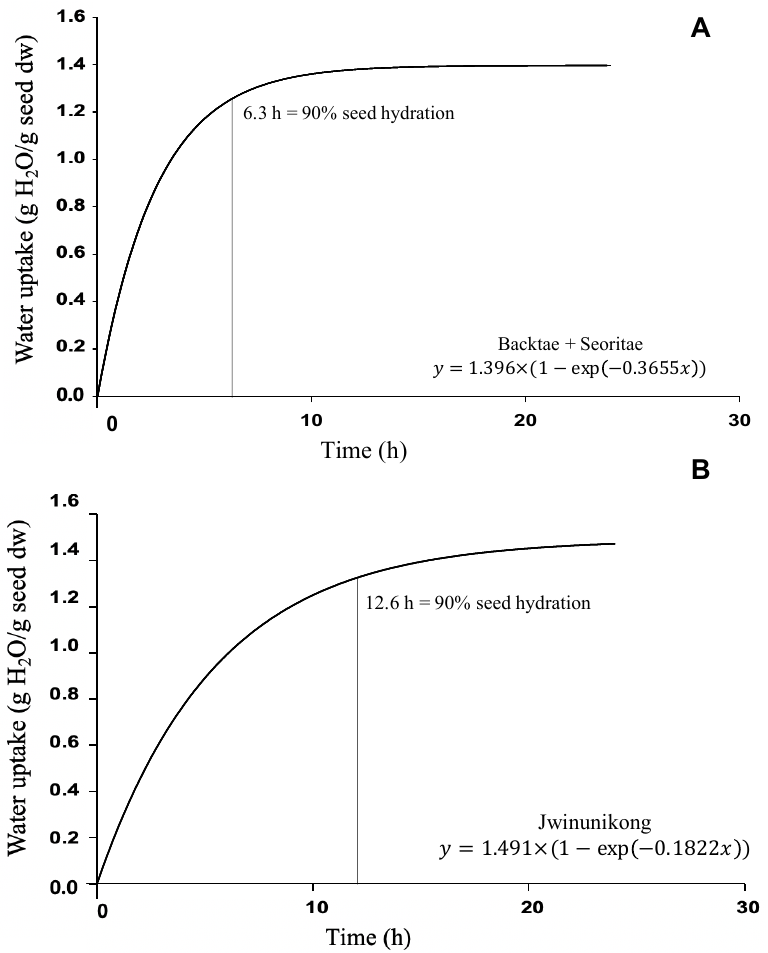
Figure 2. Water absorption kinetics of ( A ) G. max (L.) Merr., ver. Bactae, Seoritae and ( B ) R. nulubilis , ver. Jwinunikong. A common curve fitted Backtae and Seoritae.